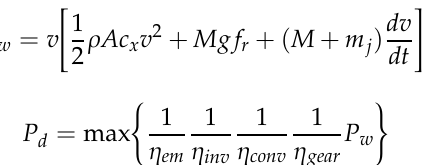
Figure 11. Change in SOC considering limitation in high power charging.